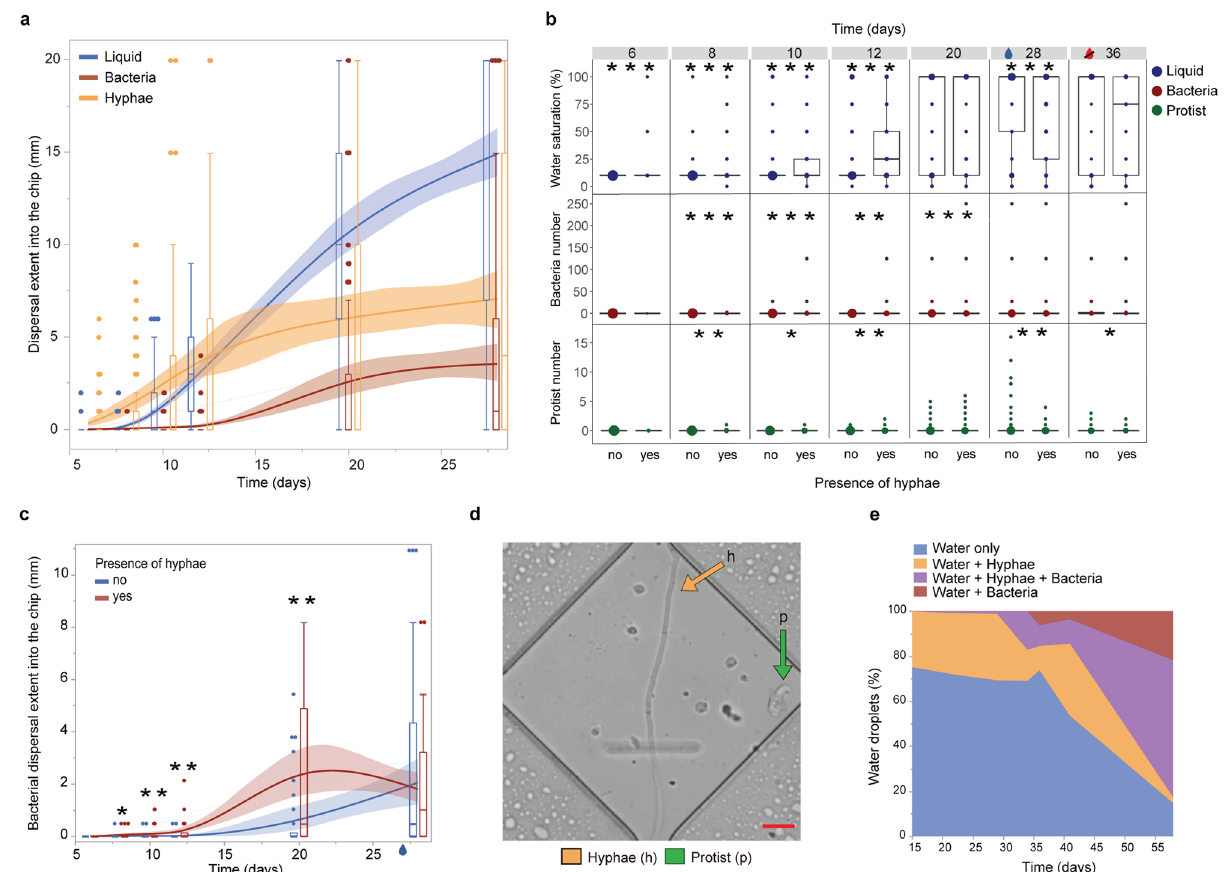
Fig. 4 Time-resolved investigation of the in fl uence of fungal hyphae on pore wetting and microbial dispersal recorded in Expt. 3: soil incubated on initially air- fi lled chips in the laboratory. a Dispersal extent of fungal hyphae, water fi lms (liquid), and bacteria into the ‘ diamond ’ channels, mean and 95%-con fi dence interval combined with boxplots with median, quartiles and outliers, n = 3 chips × 36 channels. b Presence of water (liquid) and abundance of bacteria and protists in diamond-shape widenings over time, depending on the presence of a fungal hypha. Prior to day 28, we performed a waterlogging treatment to the inoculation soil that saturated most parts of the chips ’ pore spaces, indicated by the blue droplet in b and c . Between days 29 and 36, chips were exposed to drying without any additional watering, indicated by the strikethrough red droplet in b . Boxplots with median, quartiles and outliers and the dot size indicating the number of observations, n = 3 chips × 1188 widenings. c Bacterial dispersal extent into channels with diamond- shaped widenings, depending on the presence of fungal hyphae, boxplots combined with a curve of the means and 95%-con fi dence interval, n = 3 chips × 36 channels. Prior to day 28, we performed a waterlogging treatment to the inoculation soil that saturated most parts of the chips ’ pore spaces, indicated by the blue droplet. d Example of a diamond-shaped widening along the channels with a protist along a hypha. Scale bar = 10 µ m. e Quanti fi cation of the presence of hyphae and bacteria contained within spontaneously formed water droplets within the entry system of an initially air- fi lled chip. Humidity of the inoculation soil was kept equal, no waterlogging or drying was applied. Stars in b and c denote statistically signi fi cant differences at * p < 0.05; ** p < 0.01; *** p <